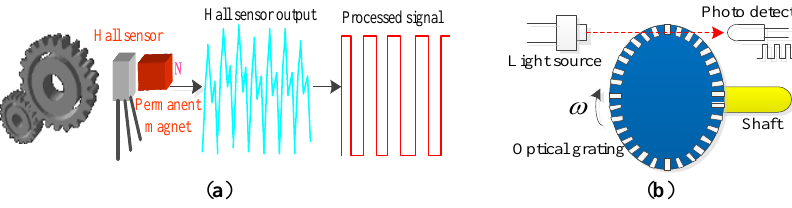
Figure 3. ( a ) Schematic diagram for the working principle of Hall speed sensors; ( b ) Schematic diagram for the principle of photoelectric speed sensors.